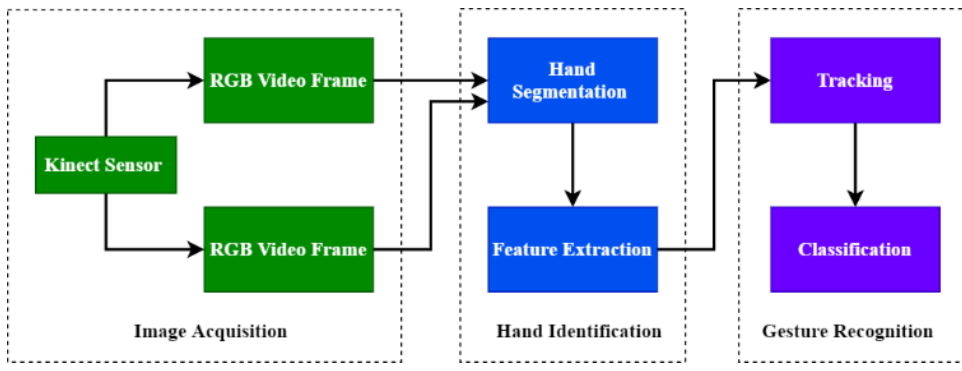
Figure 6. Standard framework for hand gesture recognition using